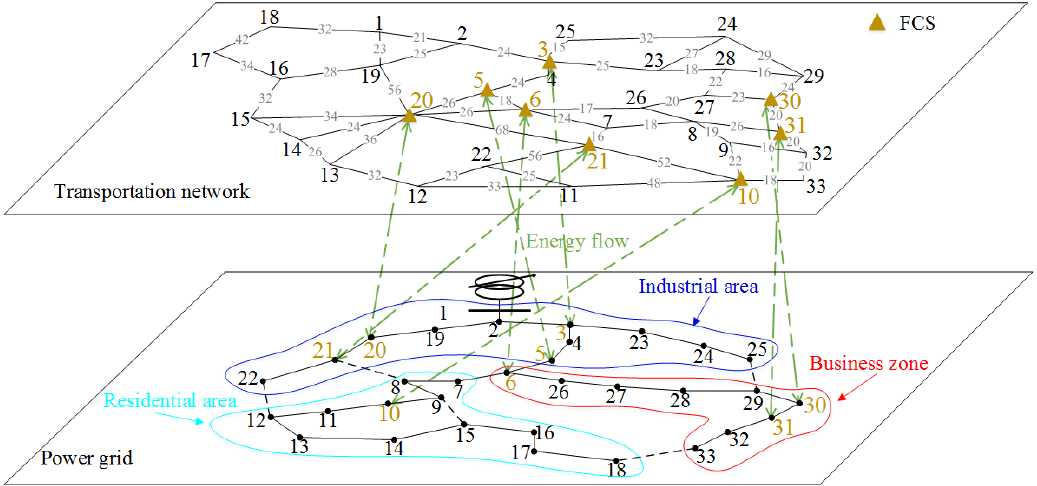
Figure 3. Topology of CTETNs.